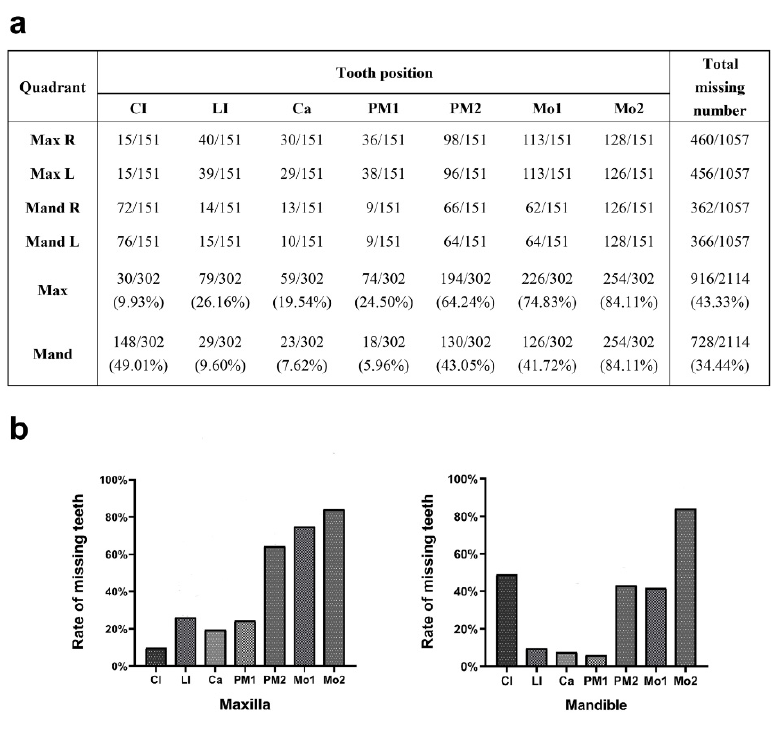
Figure 4. The pattern of PAX9-related non-syndromic tooth agenesis. ( a ) The number of missing teeth in 151 patients with PAX9 variants. ( b ) The rate of missing teeth in 151 patients with PAX9 variants was compiled at seven tooth positions in the maxillary and mandibular regions. The rate of missing teeth at different positions in the maxillary arch was statistically different using Pearson's chi-squared test, X 2 (6, N=2114) =666.98, p <0.001. The rate of missing teeth at different positions in the mandibular arch was statistically different using Pearson’s chi-squared test, X 2 (6, N=2114) =662.58, p <0.001. Max, maxillary; Mand, mandibular; CI, central incisor; LI, lateral incisor; Ca, canine; PM1, first premolar; PM2, second premolar; Mo1, first molar; Mo2, second molar.